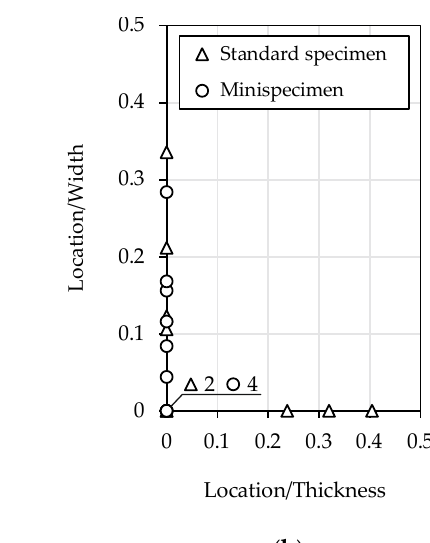
Figure 12. Overall fracture surfaces of standard specimen: ( a ) S235JR steel; ( b ) 1.4301 steel.